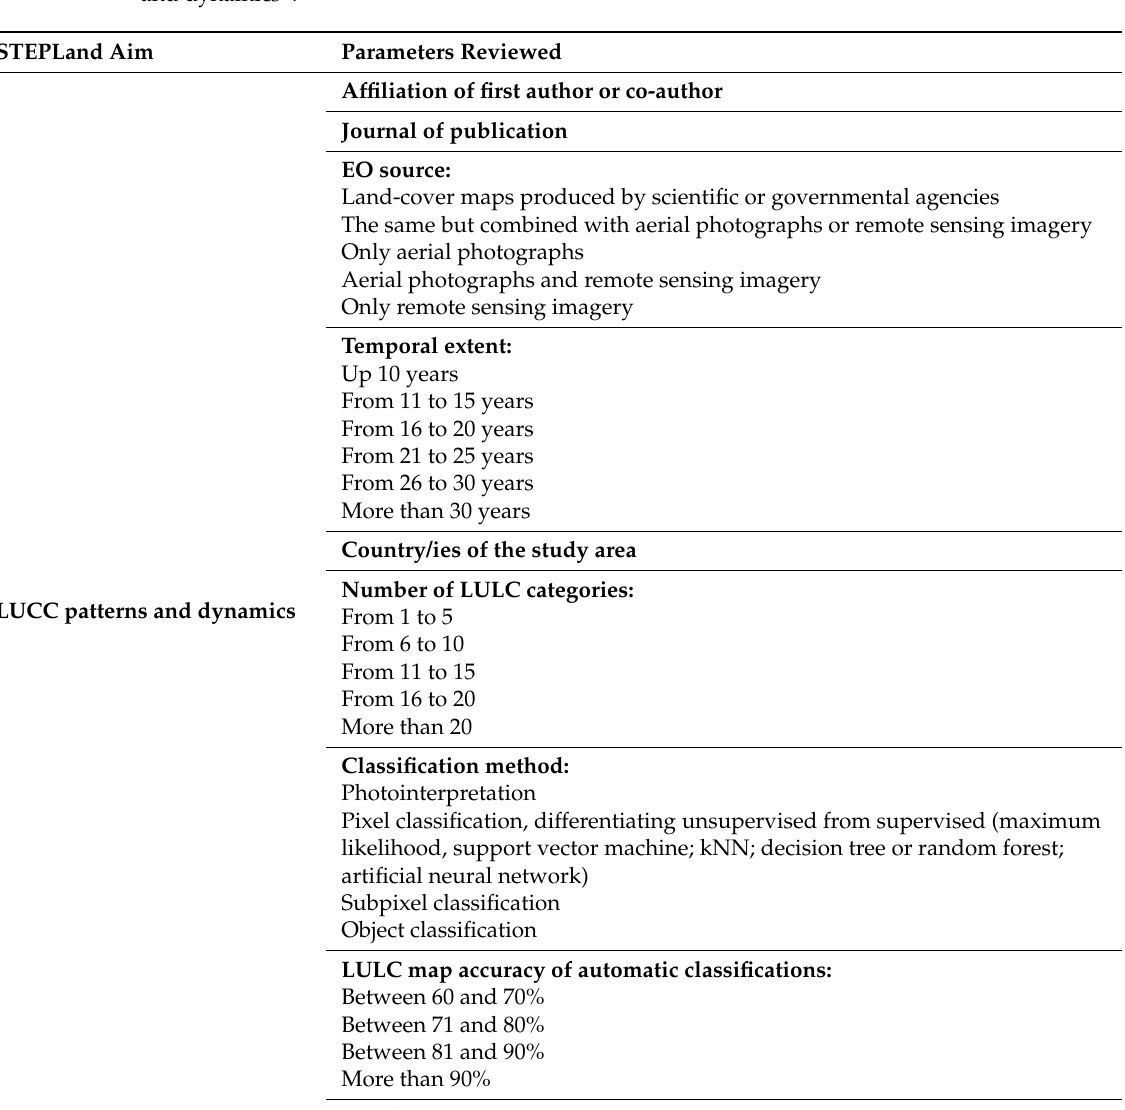
Table 1. Parameters collected in the first STEPLand step, corresponding to “LUCC patterns and